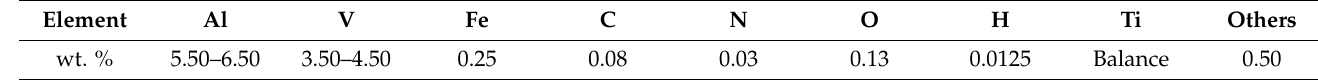
Table 1. Specific composition of Ti-6Al-4V ELI alloy powder.